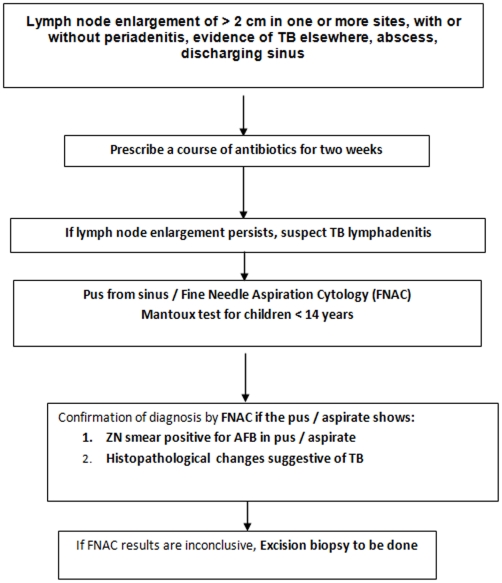
Diagnostic algorithm for peripheral lymph node TB.